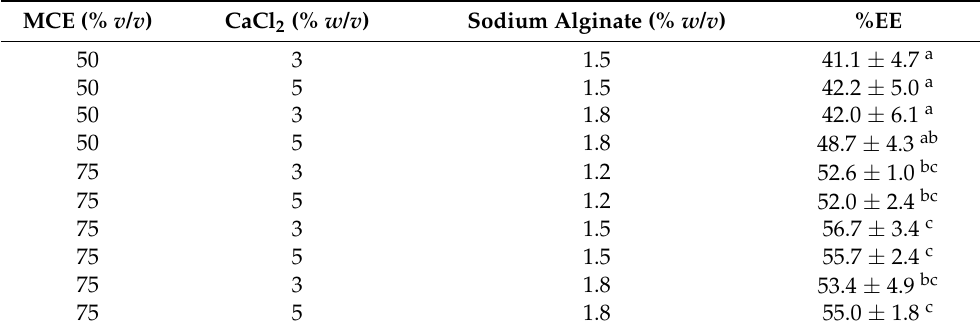
Table 1. The percentage encapsulation efficiency (%EE) of beads with different concentrations of M. chinensis extract (MCE), calcium chloride solution (CaCl 2 ), and sodium alginate. MCE (% v / v